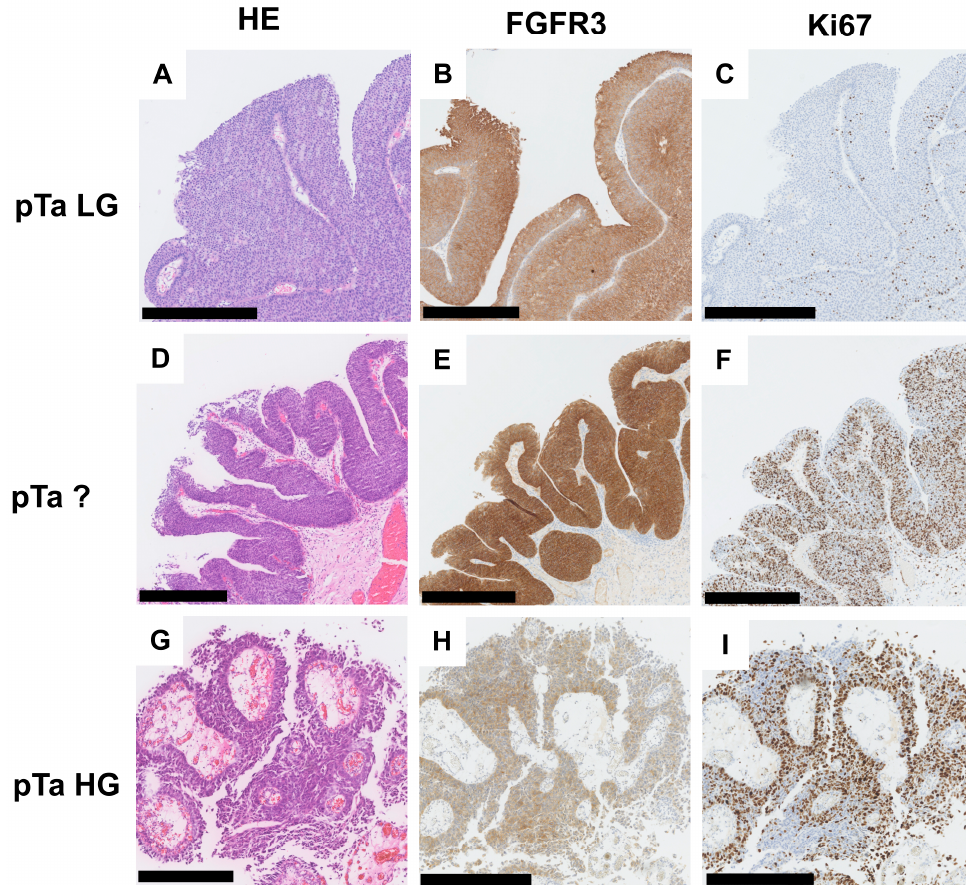
Figure 1. FGFR3 and Ki67 protein expression in papillary non-invasive (pTa) bladder tumors. Immunohistochemical staining for FGFR3 and Ki67 protein of representative tumors are shown. ( A – C ) pTa low grade (LG) tumor: ( A ) Hematoxylin and Eosin (HE) staining; ( B ) strong FGFR3